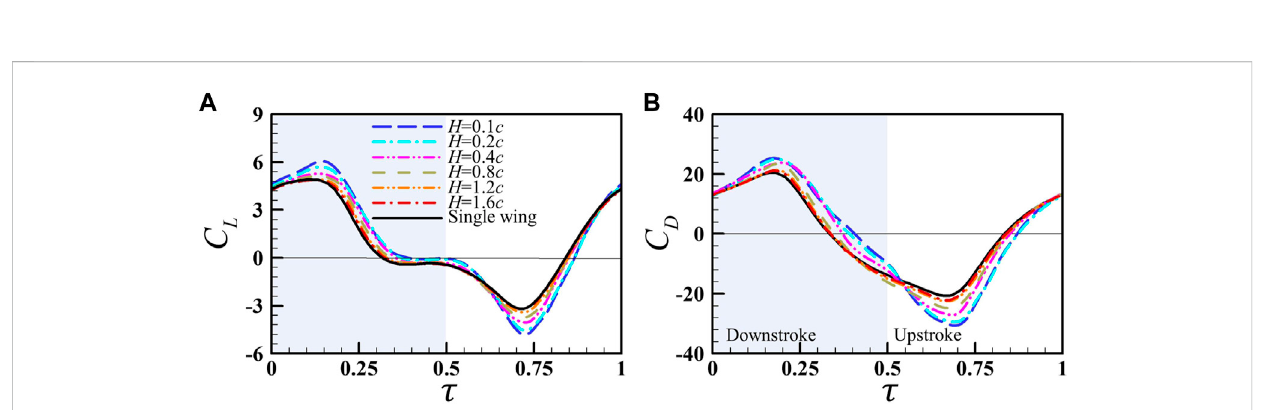
FIGURE 13 Instantaneous (A) lift and (B) drag coef fi cients of the right wing of the wing pair at different wing – wing separations ( H ), with the results of the single wing for